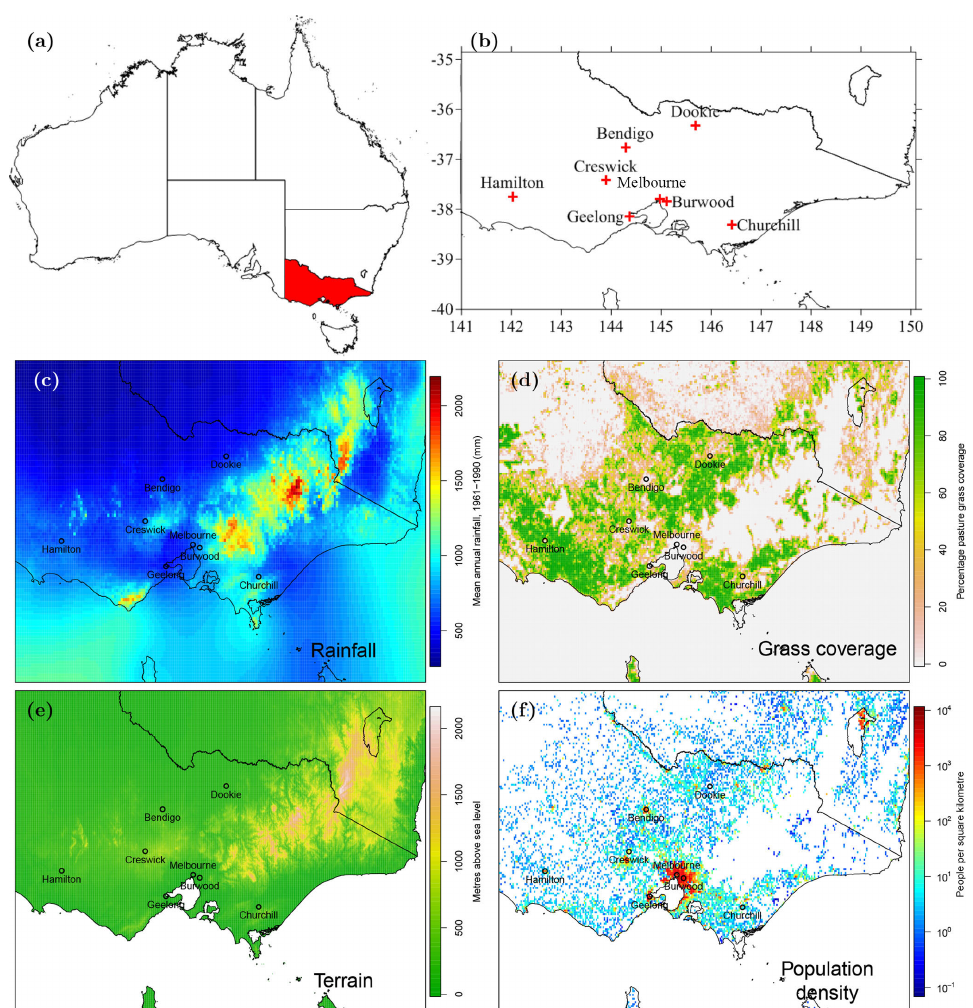
Figure 1. Maps of (a) Victoria within Australia, (b) pollen observing sites within the domain, (c) mean annual rainfall, (d) pasture grass coverage, (e) terrain and (f) population density. Data sources: (c) BOM, (d) ABARES, (e) Geoscience Australia and (f) the Bureau of